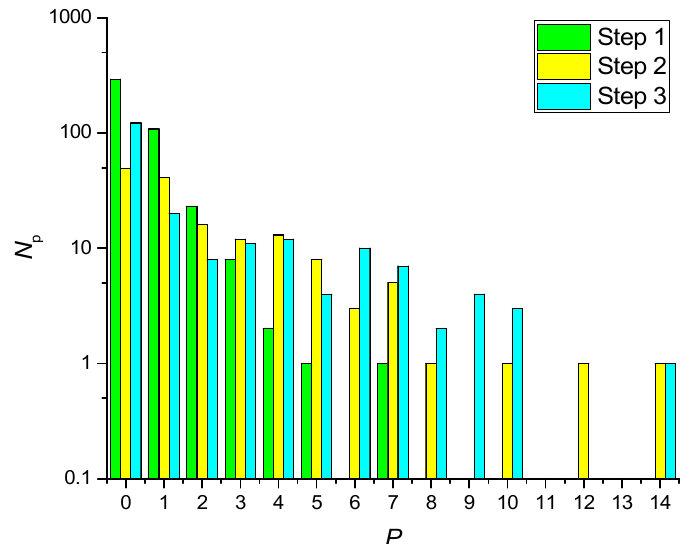
Figure 12. Diagram of the solution number N P distribution against the value of P for three subsequent steps of the network training algorithm. The total number of attempts at each step is 1000. The maximum value P = 14 was obtained at the following parameters: ( I ON = 722 µ A, I OFF = 1034 µ A, I 0 = 1020 µ A, I 10 = 887 µ A, s r =0.10176 V, s o = 0.29202 V, s m = 0.202 V, U n = 80 µ V, η th =